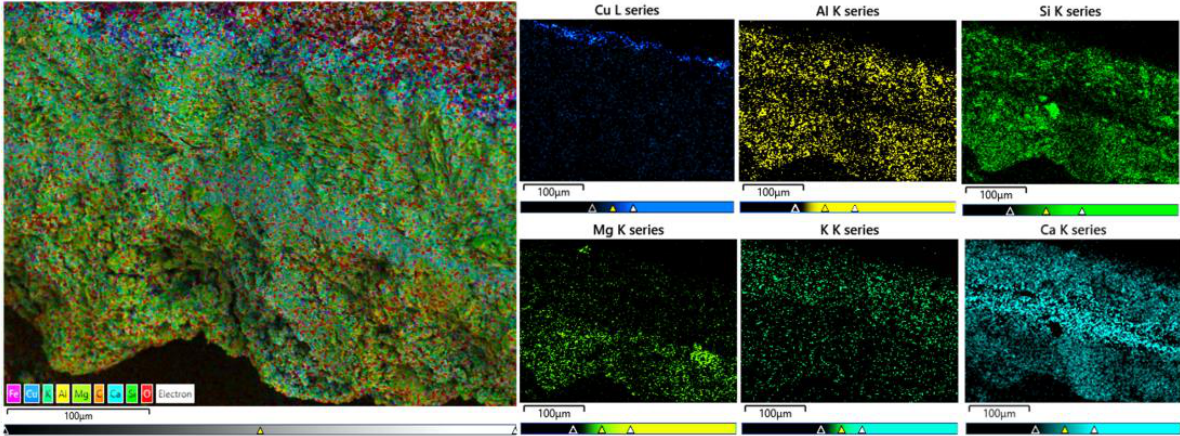
Figure 9. Result of elemental mapping of a part of mural sample.